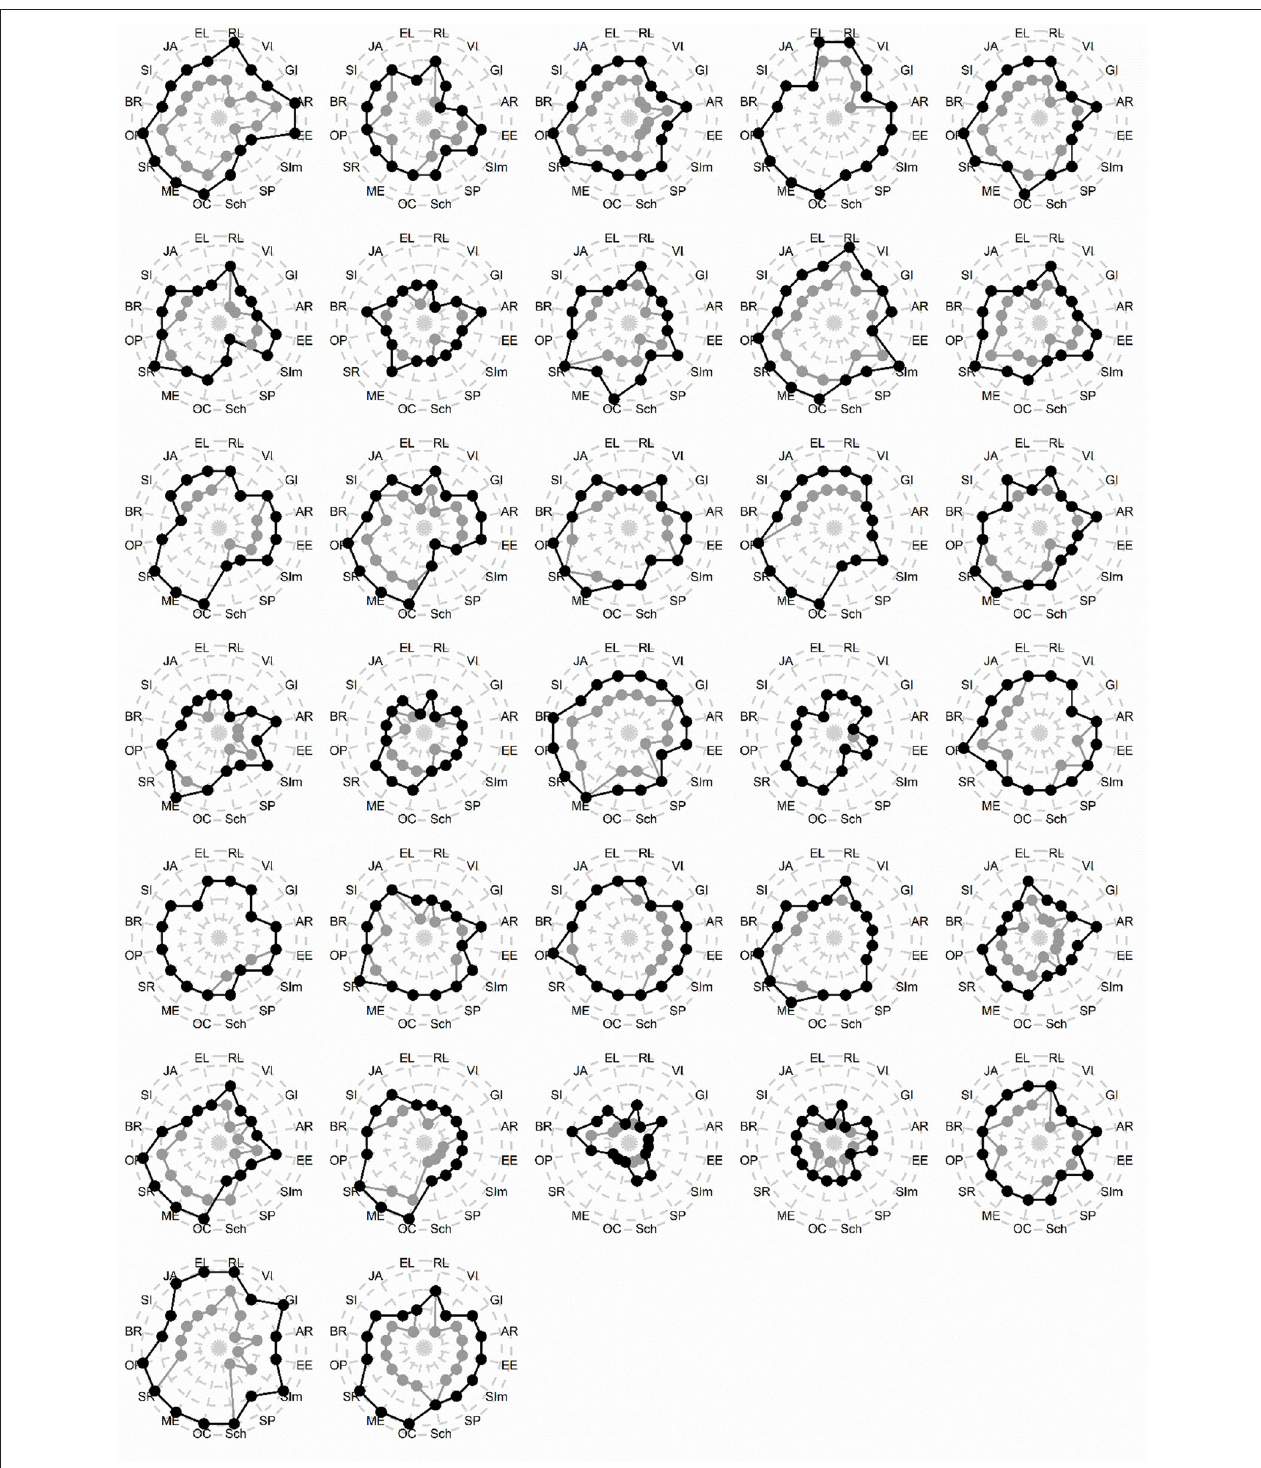
FIGURE 2 | Individual data ( N = 32) for cognitive and socio-emotional assessment. Each radar plot represents a child enrolled in TIPA-T. Grayline: before therapy; black line: after therapy. Note that Subject 28 (before last line, middle column) was an extreme outlier and was removed from statistical analysis. Socio-emotional domains (top): BR, behavior regulation; SI, social interaction; JA, joint attention; EL, expressive language; RL, receptive language; VI, vocal imitation; GI, gestural imitation; AR, affective relation; EE, emotional expression. Cognitive domains (bottom): SIm, self-image; SP, symbolic play; Sch, object-relation schemata; OC, operational causality; ME, means–ends; SR, spatial relations; OP, object permanence).